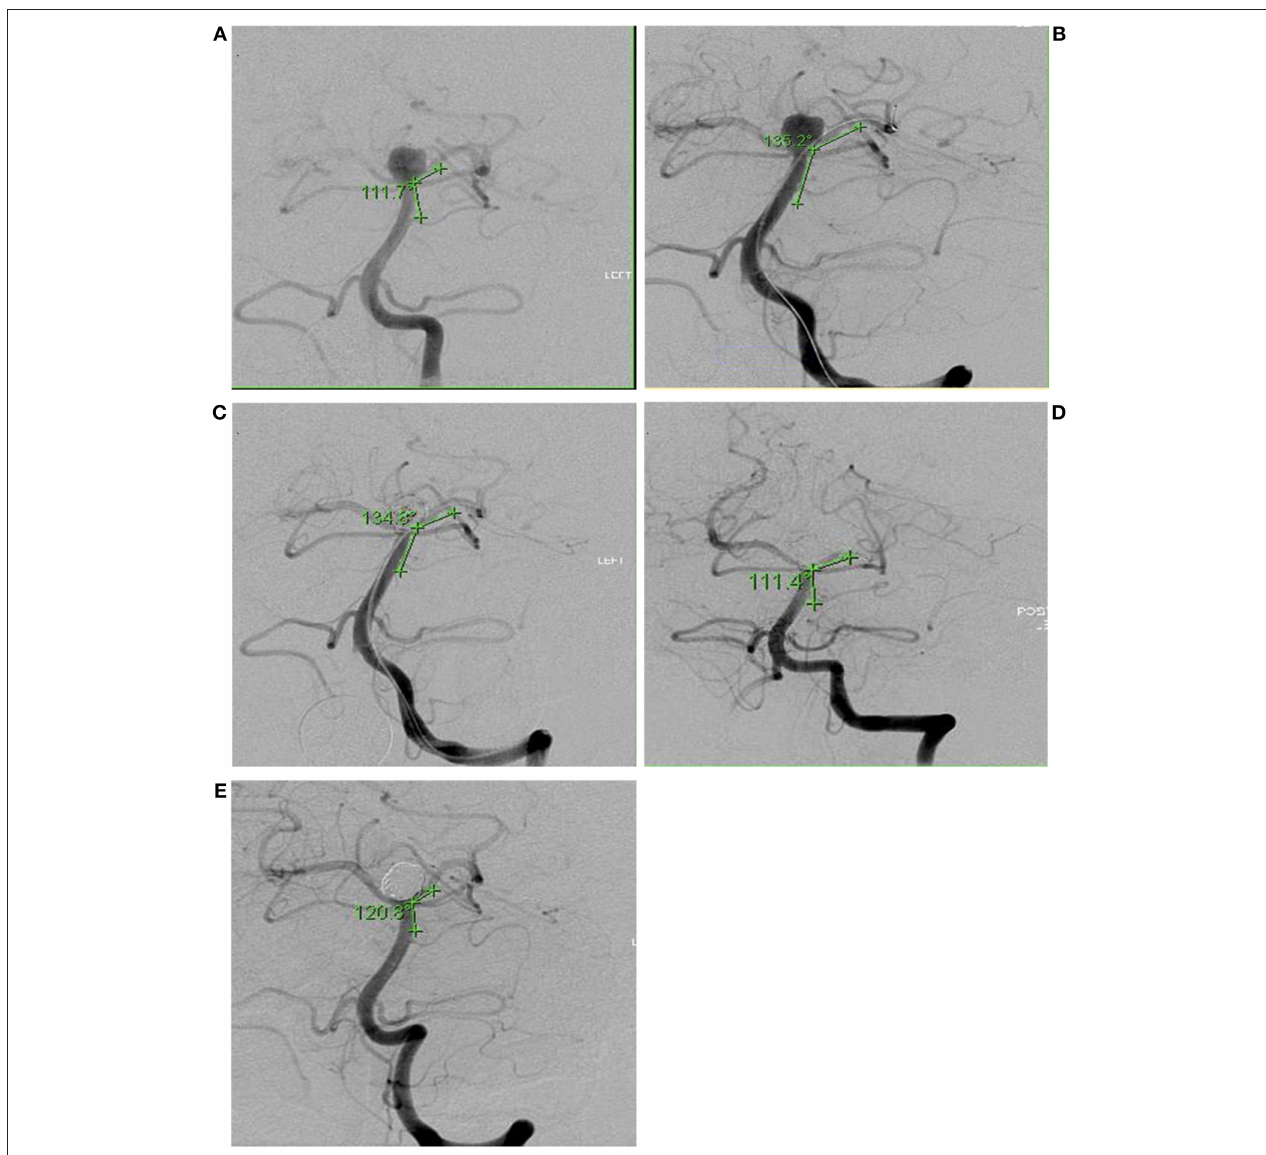
FIGURE 1 | Intra-operative angiography of Subject 6 showing angle of incidence between parent vessel and branch vessel to receive second microcatheter. Angles were measured in 5 conditions: (A) Before device insertion (111.7 ◦ ), (B) During microcatheter insertion (135.2 ◦ ), (C) During embolization with microcatheters and coils (134.8 ◦ ), (D) After completion of embolization and removal of all devices (111.4 ◦ ), (E) Follow-up angiography 27 months later (120.8 ◦